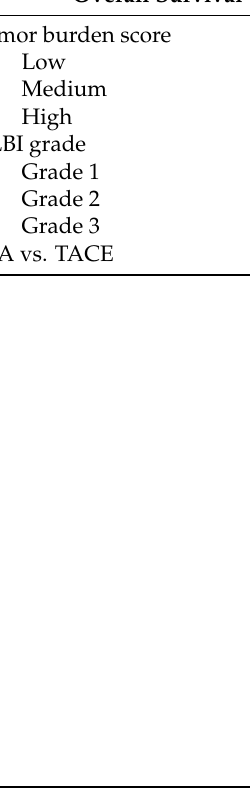
Table 2. Cont. Univariate Analysis Multivariate Analysis